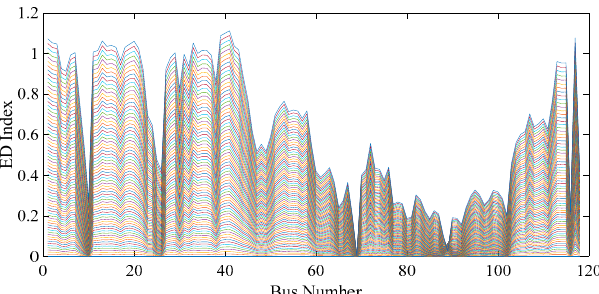
Figure 18. The ED index profiles in terms of the load demand increment in the MLP with the IEEE 118-bus test system.